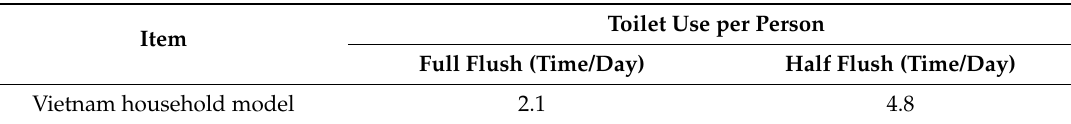
Table 8. Toilet usage in Vietnamese households